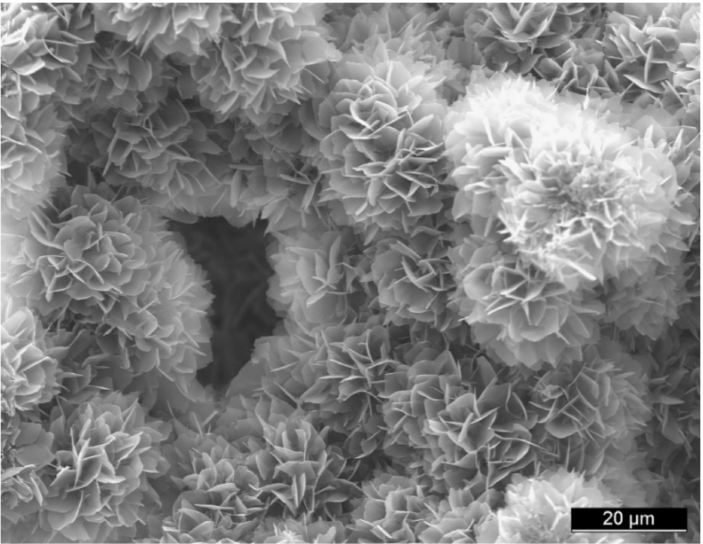
Figure 16. A typical microstructure of a CaPO 4 cement after hardening. The mechanical stability is provided by the physical entanglement of crystals. Reprinted from Ref. [737] with